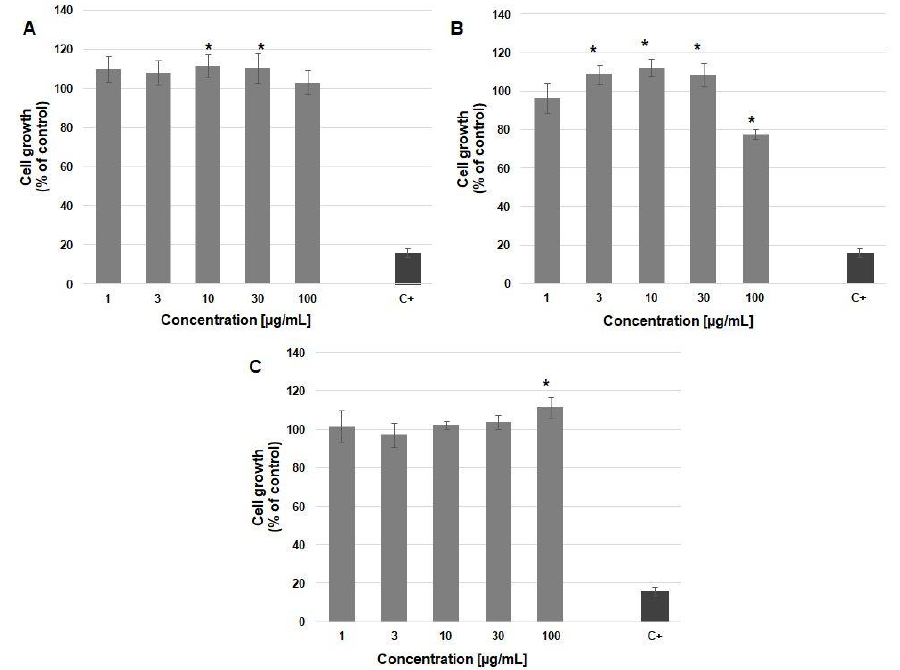
Figure 7. Growth of HaCaT cells in the presence of ( A ) (p-AA-CH 2 -HP) n ; ( B ) [(p-AA-CH 2 -HP) x -co-(HB) y ]; and ( C ) p-anisic acid. Each bar represents the mean ± SD; * p < 0.05 versus the control group (analysis of variance, ANOVA); C+—positive control.